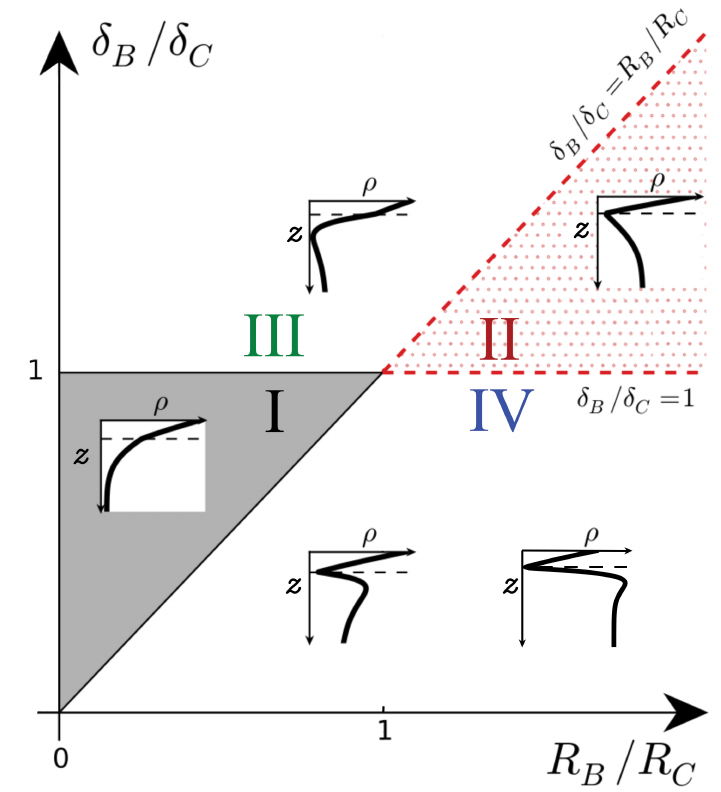
Figure 1. Schematic density profiles ρ ( z ) in the ( R B / R C , δ B / δ C ) parameter plane for R A and R C > 0. The dashed line shows the location of the reaction front. I: monotonic decreasing, II: minimum at the reaction front, III: minimum below the reaction front, IV: minimum at the reaction front followed by a maximum. Adapted from